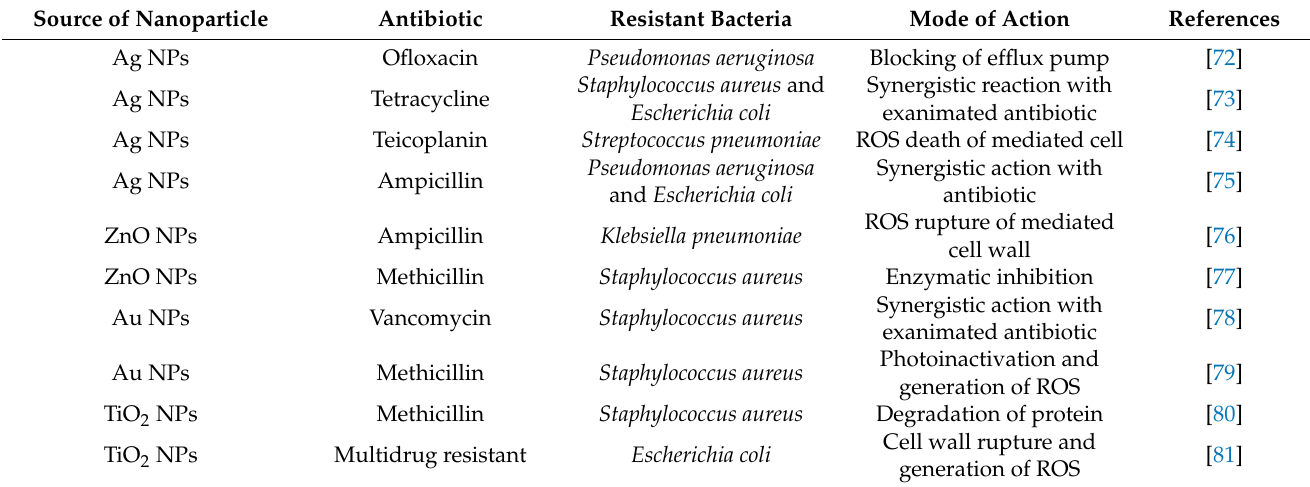
Table 1. The antimicrobial properties of nanoparticles and antibiotic composite. Source of Nanoparticle